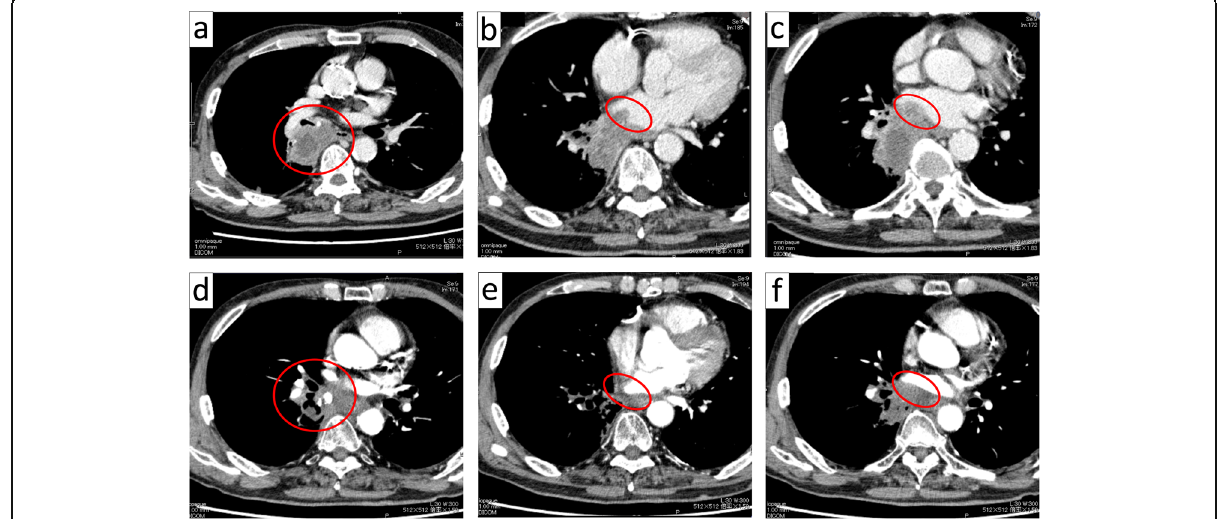
Fig. 1 Chest computed tomography (CT) before chemoradiotherapy (CRT) ( a – c ) and before surgery ( d – f